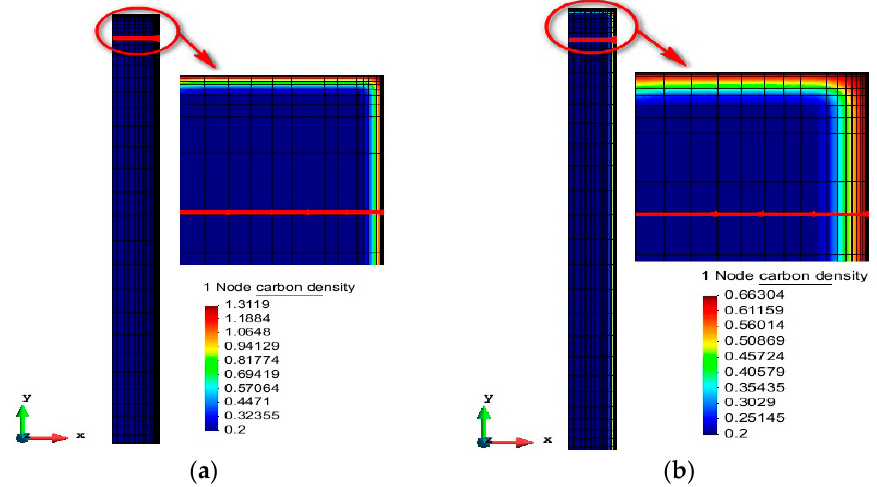
Figure 6. Carbon concentration distribution. ( a ) Vacuum carburizing of process 1; ( b ) Vacuum car- burizing of process 2.